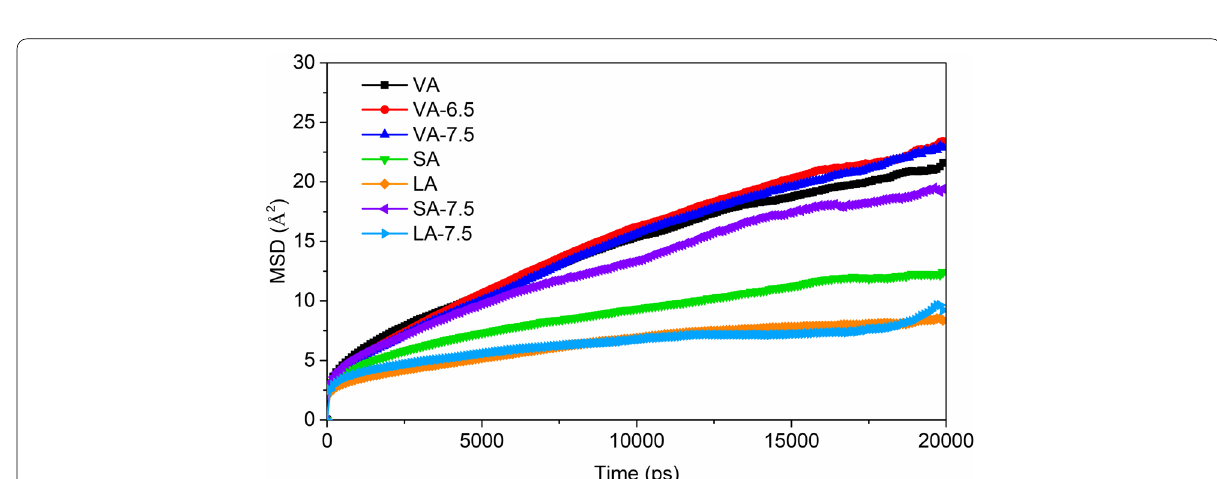
Fig. 16 MSD Curves of the Asphalt Models during Self-Healing Process at the Temperature of 298